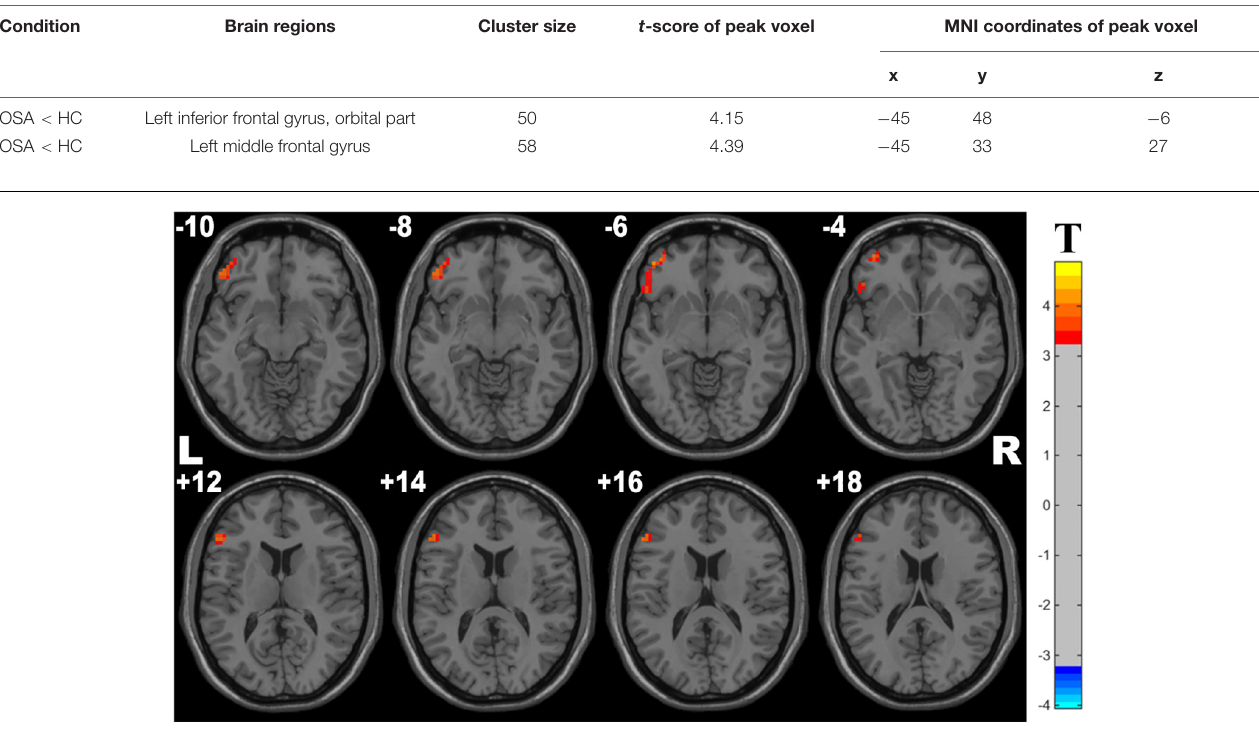
FIGURE 3 | Cluster with significantly decreased ReHo in OSA children compared with controls (with GRF correction, voxel level p < 0.001, cluster level p < 0.05).